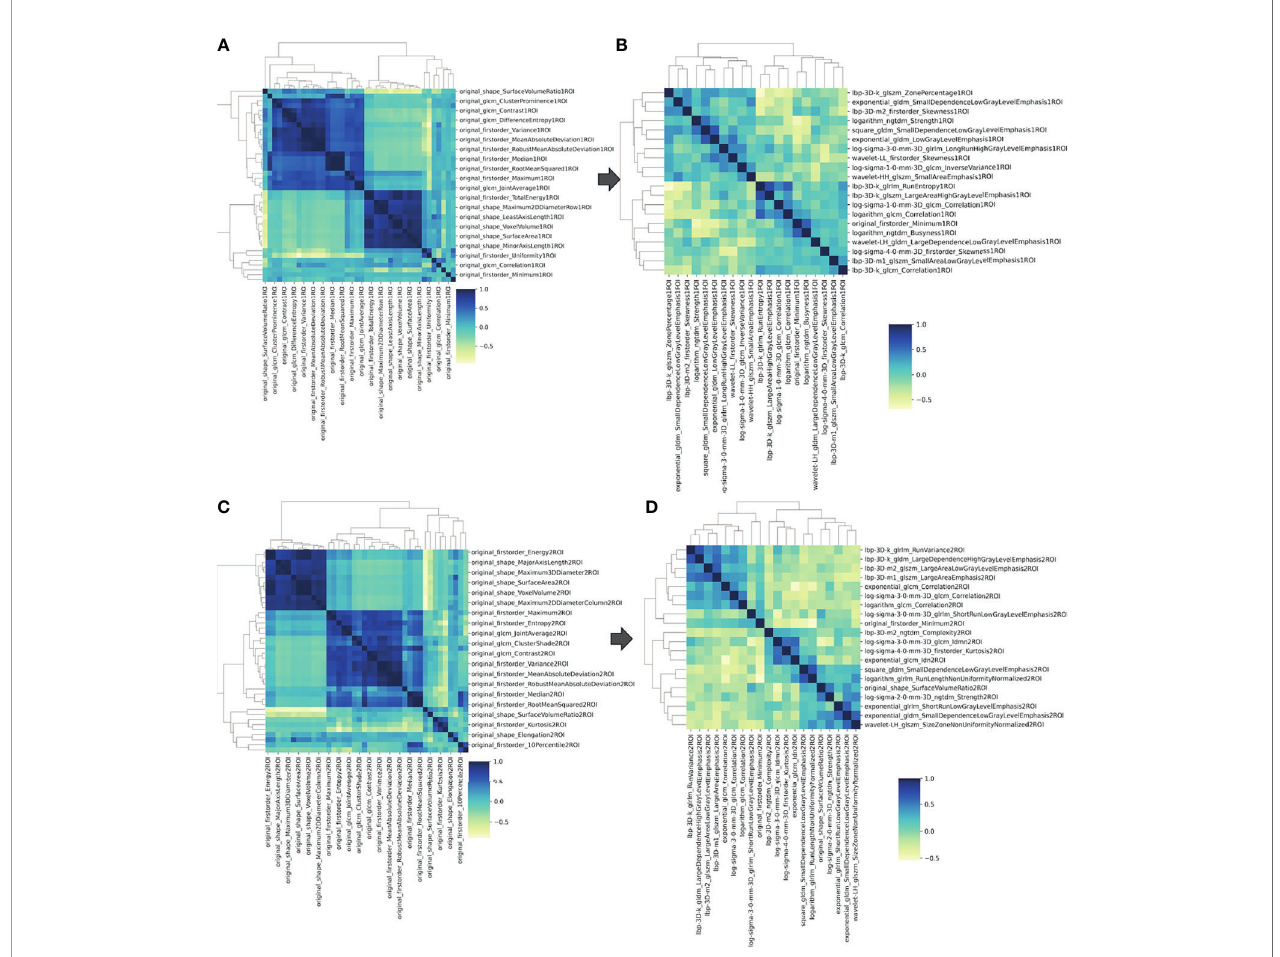
FIGURE 4 | The Pearson correlation heat maps of radiomics features. (A) Sixty of the original 1,740 radiomics features of tumoral ROI; (B) 20 selected radiomics features of tumoral ROI; (C) 60 of the original 1,740 radiomics features of tumor-to-brain interface ROI; (D) 20 selected radiomics features of tumor-to-brain interface ROI. ROI, region of